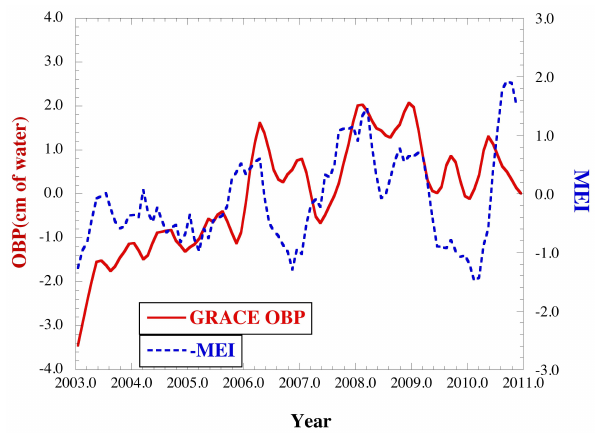
Fig. 7. Time-series of low-pass filtered GRACE OBP from Fig. 6b (left axis) and the negative of the MEI (right axis). The negative value of 1 WSC is shown to better see the correspondence since OBP and MEI are negatively correlated.